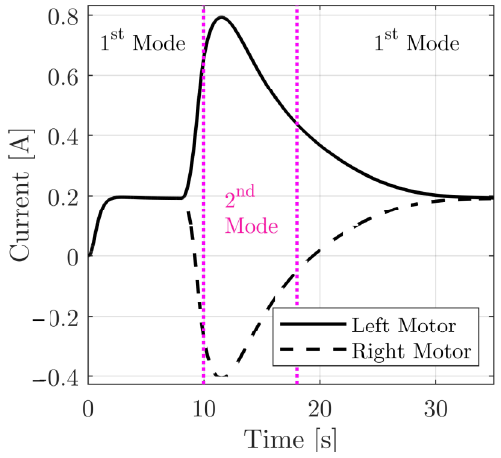
Figure 4. Heading angle of the vehicle.